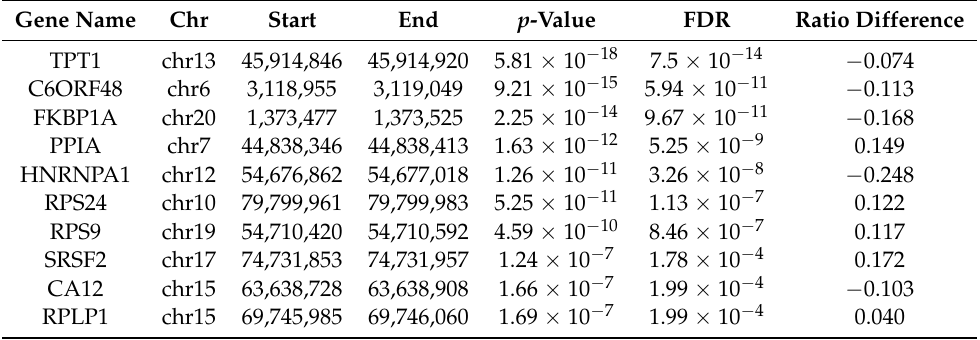
Table 2. Top 10 significant splicing events between A549 mock-treated and SARS-CoV-2 infected